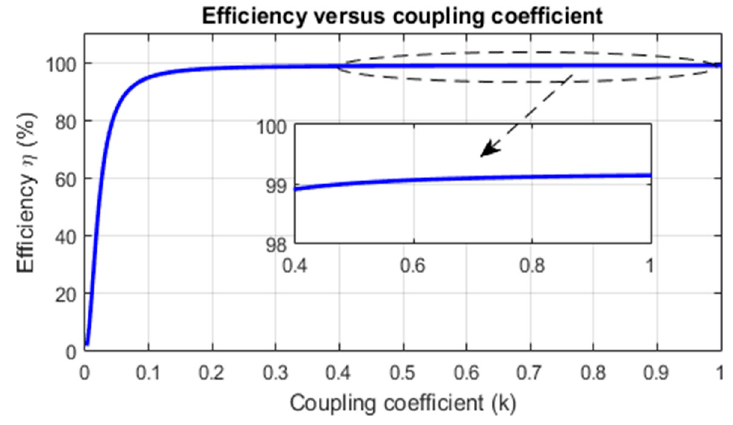
Figure 7. Efficiency variations of a WPT charger as a function of the coupling coefficient. Table 1. Parameters used for plotting Equation (13). Parameter